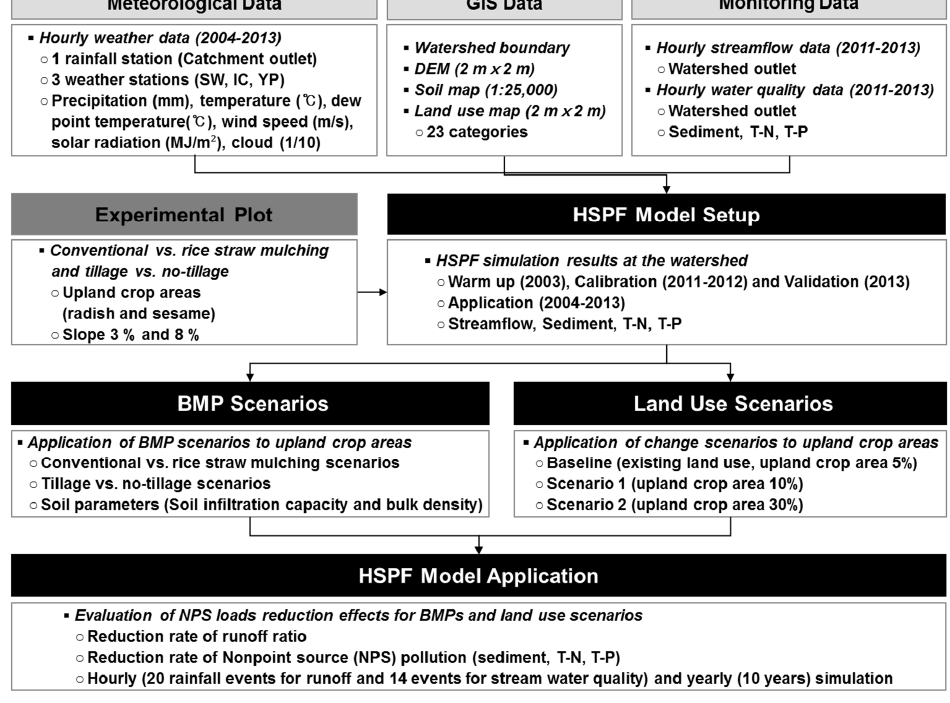
Figure 1. Flowchart of the study procedure.